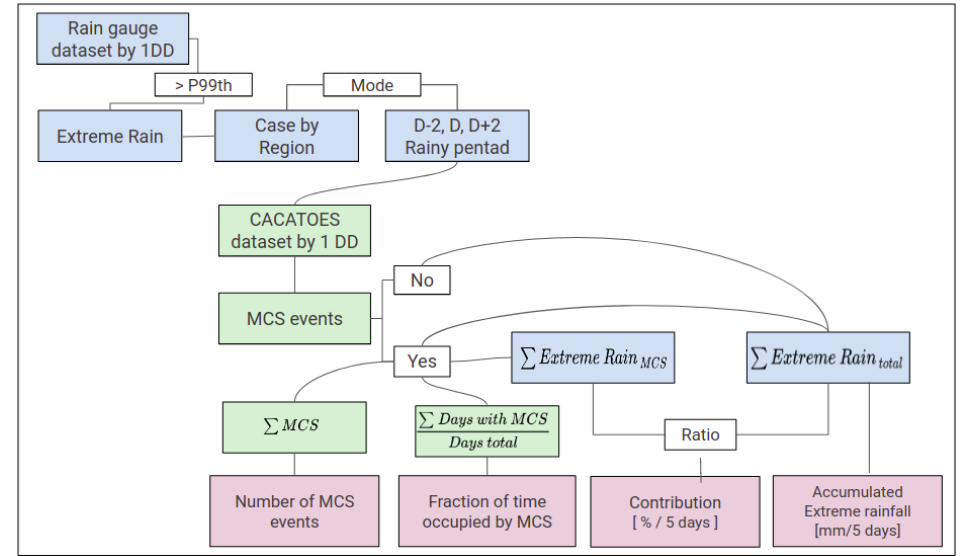
Figure 2. Schematic flowchart to describe variable extracted from CACATOES dataset and rain gauges dataset, considering rainfall values above the 99th percentile